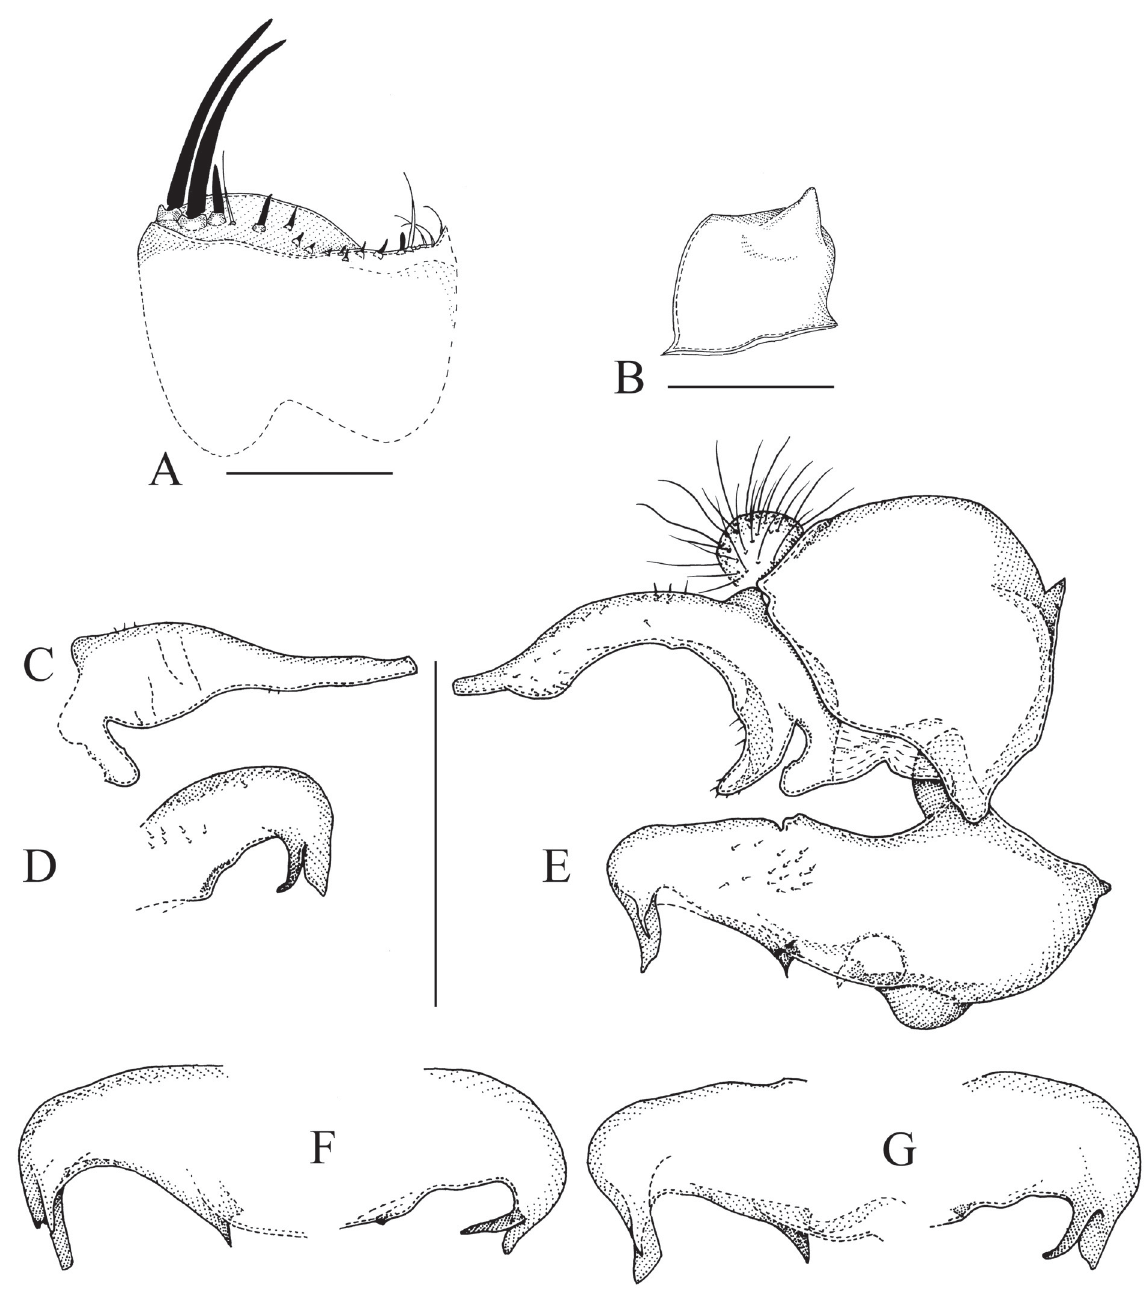
Fig. 98. Sphegina (Asiosphegina) vietnamensis sp. nov., holotype, ♂ (A–E), paratype 1 (F) and paratype 2 (G). A . Sternum IV, ventral view. B . Sternum VII, ventral view. C . Left surstylus, lateral view. D . Left superior lobe with associated parts, lateral view. E . Genitalia, right side, lateral view. F–G . Left and right superior lobe, lateral view. Scale bars = 0.5